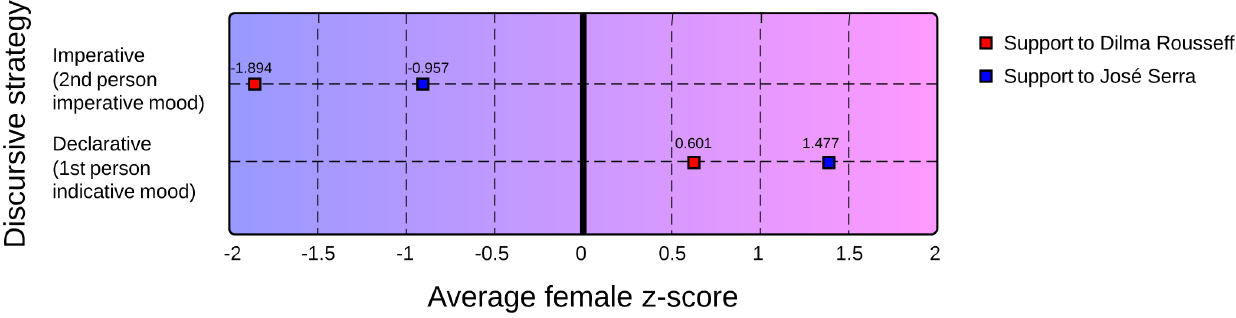
Figure 4. Average female z-scores of group 1 (’’declarative tags’’) and group 2 (’’imperative tags’’). Hashtags on group 2 are more used by men while those on group 1 are more common among women. Standard deviations are the following: -1.894 6 0.325, -0.957 6 0.424, 0.601 6 0.668, 1.477 6 0.574.